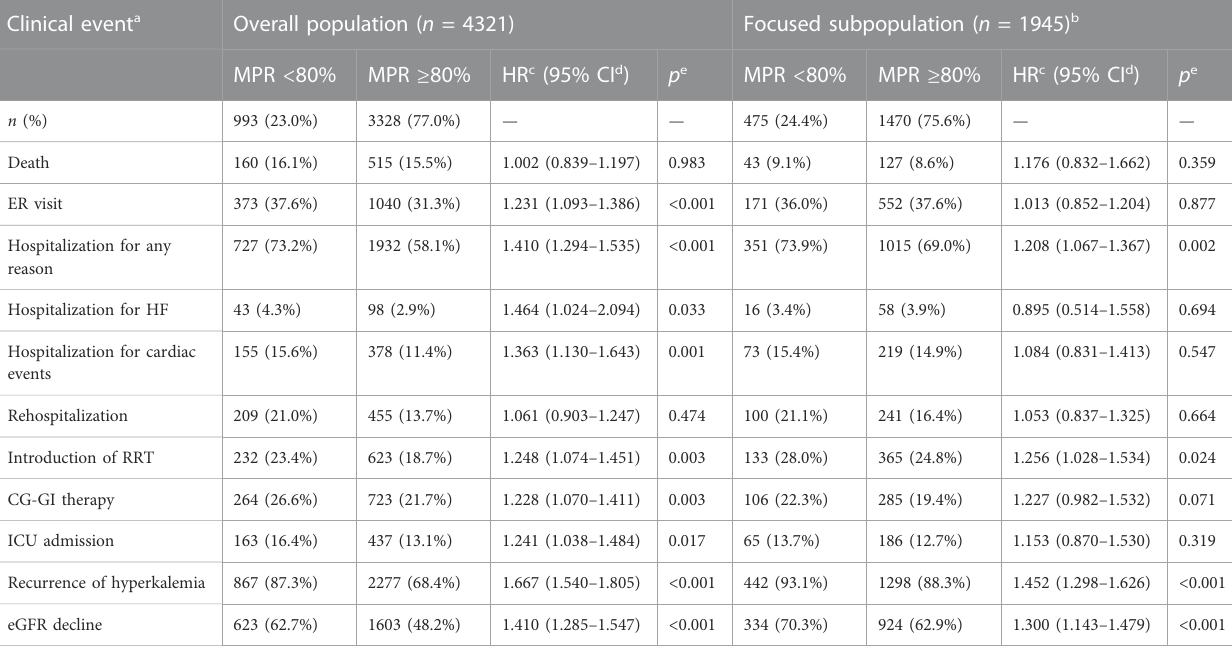
TABLE 5 Association between the MPR for potassium binders and clinical events in patients with hyperkalemia (overall population and focused subpopulation). Clinical event a Overall population ( n =